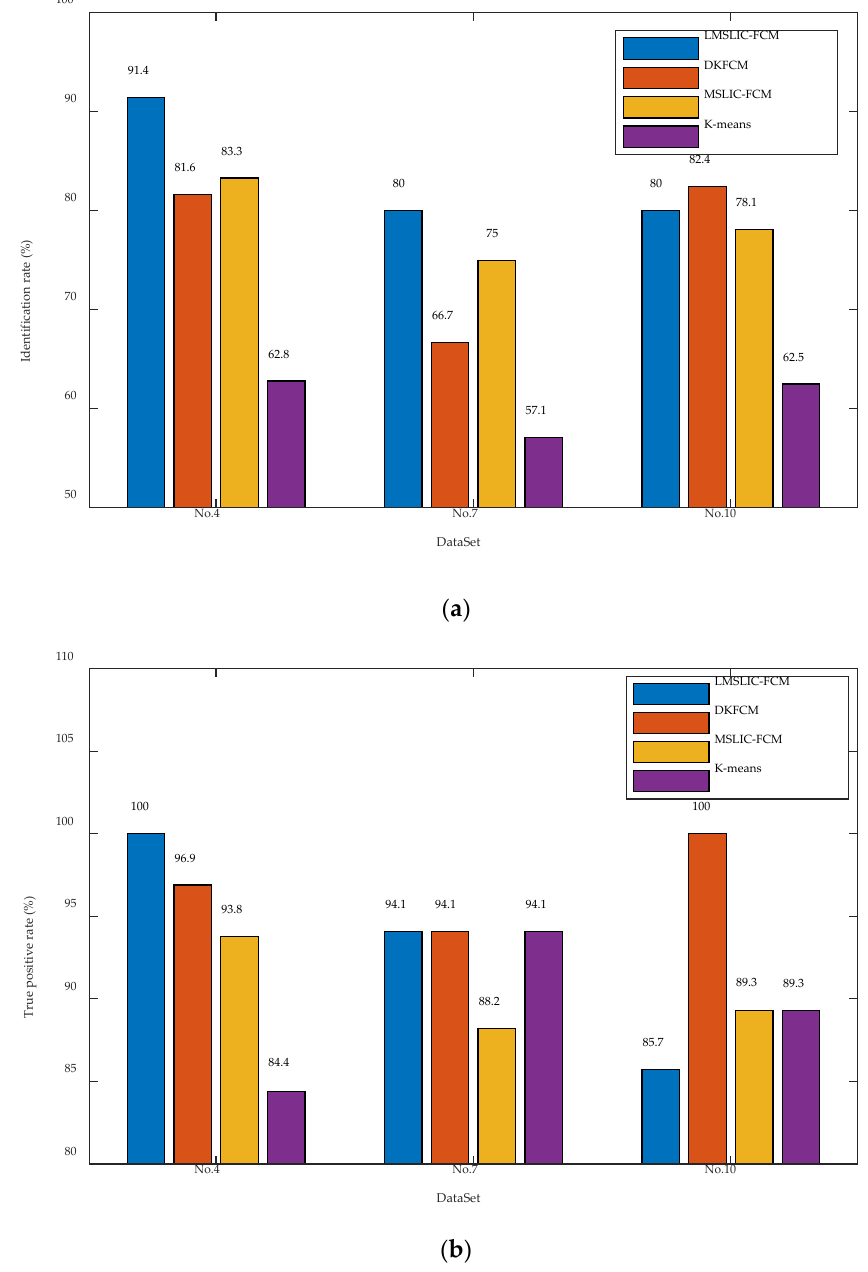
Figure 7. Identification rate and false positive rate of each experiment on manganese nodule data ( a ) identification rate ( b ) true positive rate.